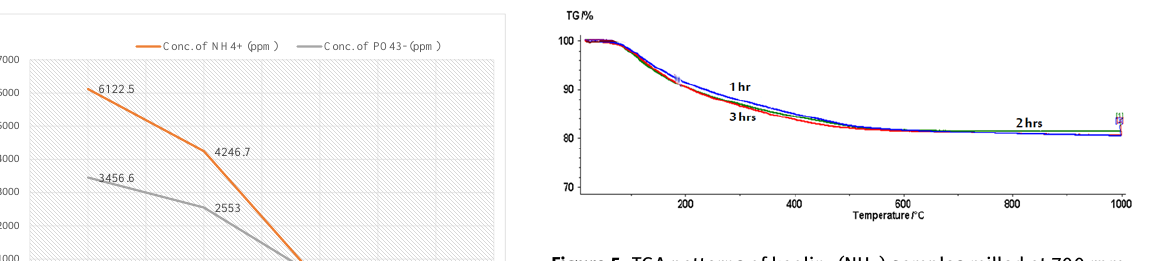
Figure 5: TGA patterns of kaolin–(NH 4 ) samples milled at 700 rpm for different duration and PO 3− nutrients in (ppm) released Table 3: Concentration of NH + 4 4 from kaolin–(NH 4 ) 2 HPO 4 samples milled at 700 rpm for various